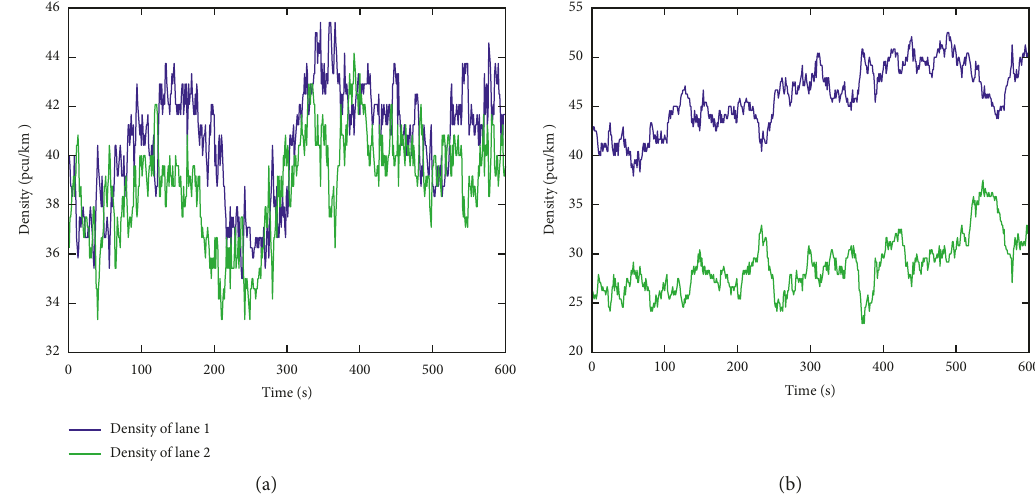
Figure 4: (a) Traffic density of two lanes in Group A. (b) Traffic density of two lanes in Group B.